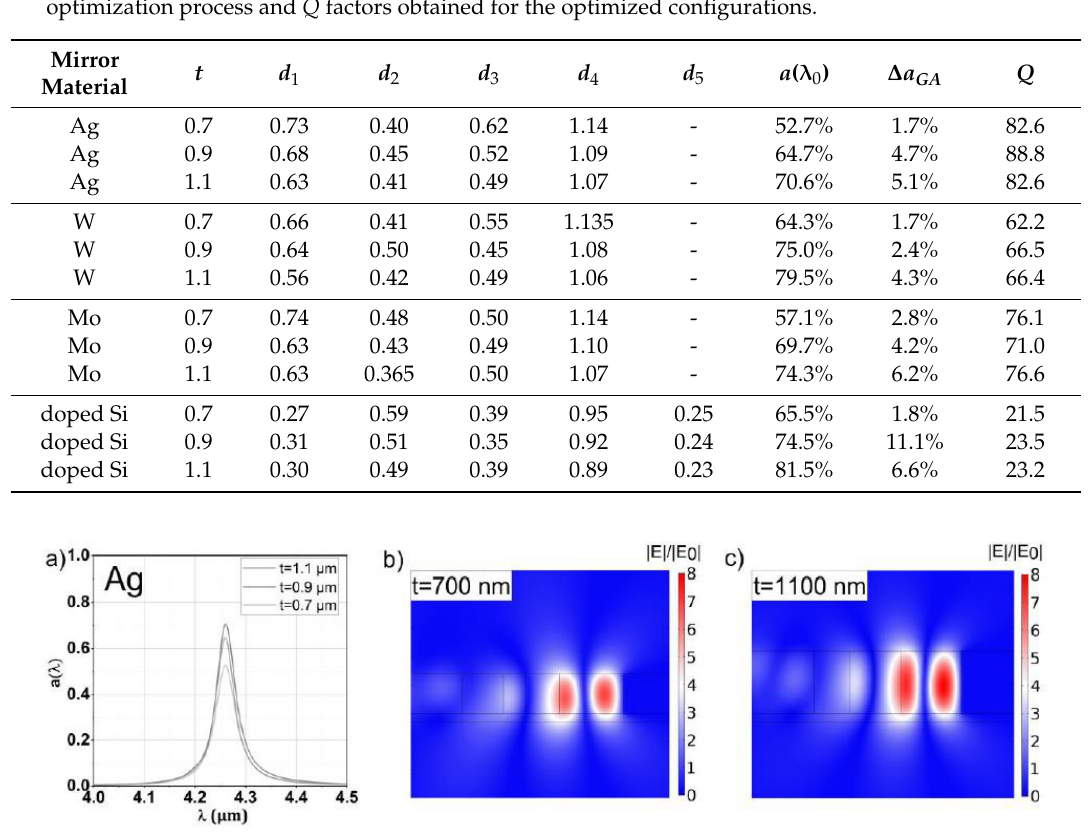
Figure 4. ( a ) Spectral response of the µ -GA optimized Ag-based STP structures for slab thicknesses of 0.7, 0.9 and 1.1 µ m, respectively, and a resonant wavelength of 4.26 µ m. The relative field enhancements of the thinnest (0.7 mm) and thickest (1.1 µ m) slab are shown in panels ( b , c ), respectively. The high Q factor of the resonance is reflected by a 6- to 8-fold enhancement of the electric field depending on t